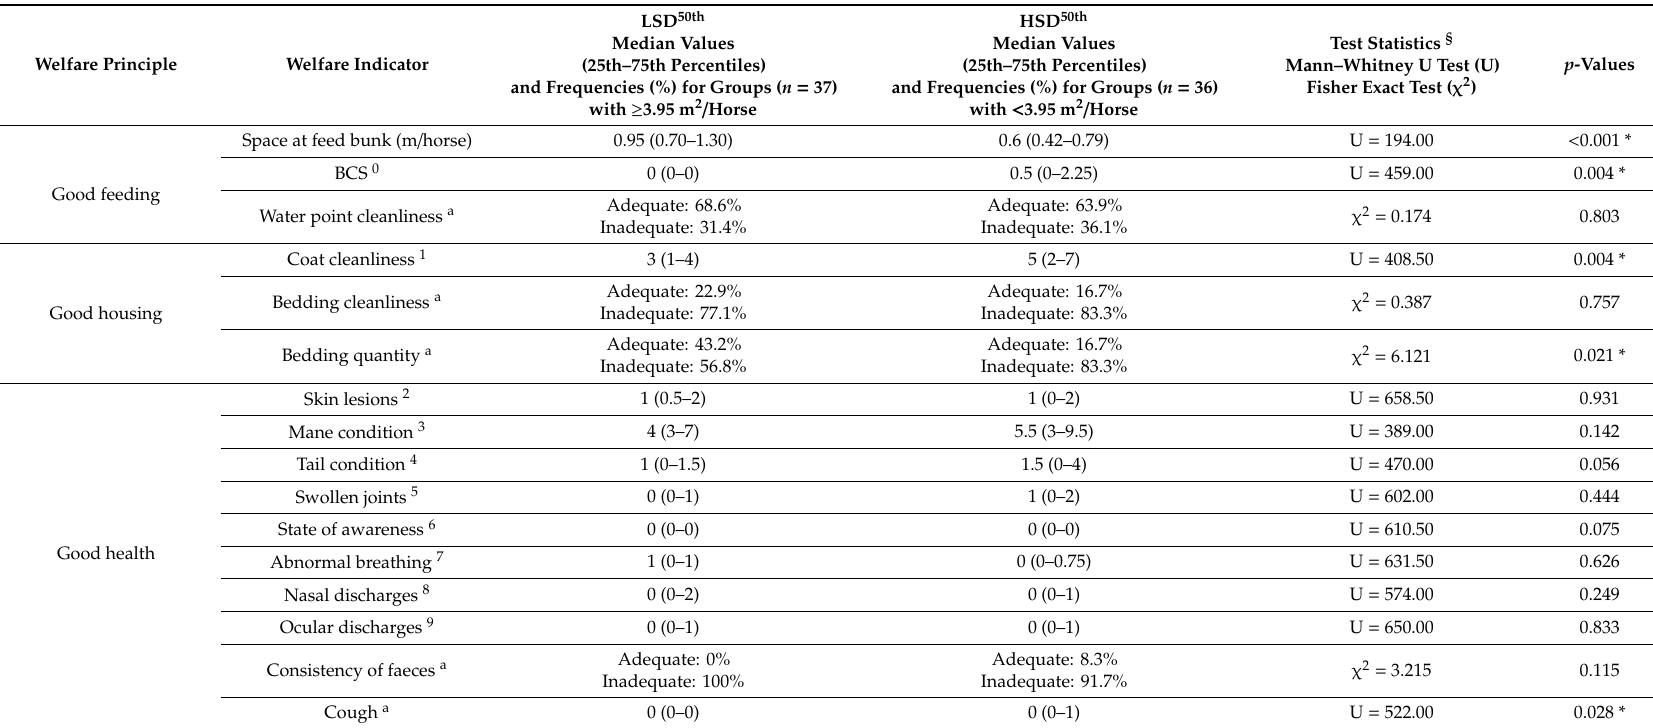
Table 3. Statistical analysis performed using the median cut-o ff value for the stocking density (3.95 m 2 / horse). Nondichotomous variables are expressed as the median number of horses (plus 25th–75th percentiles) within pens that show a specific score or health condition or are performing a specific behaviour. Space at the feed bunk is expressed as the median (plus 25th–75th percentiles) length in metres available per horse. Nondichotomous variables were analysed using the Mann–Whitney U test: the test statistic (U) and p -values are reported. Dichotomous variables are expressed as frequencies (%) and were analysed using the Fisher exact test: the test statistic ( χ 2 ) and p -values are reported. Data were considered significant for p -values <